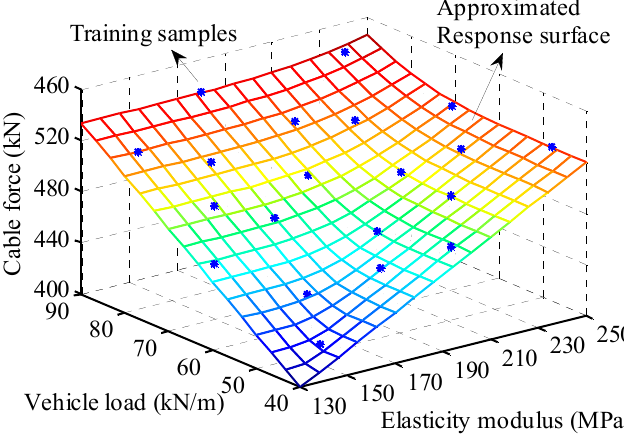
Figure 11. Finite element model in ANSYS of the suspension bridge.